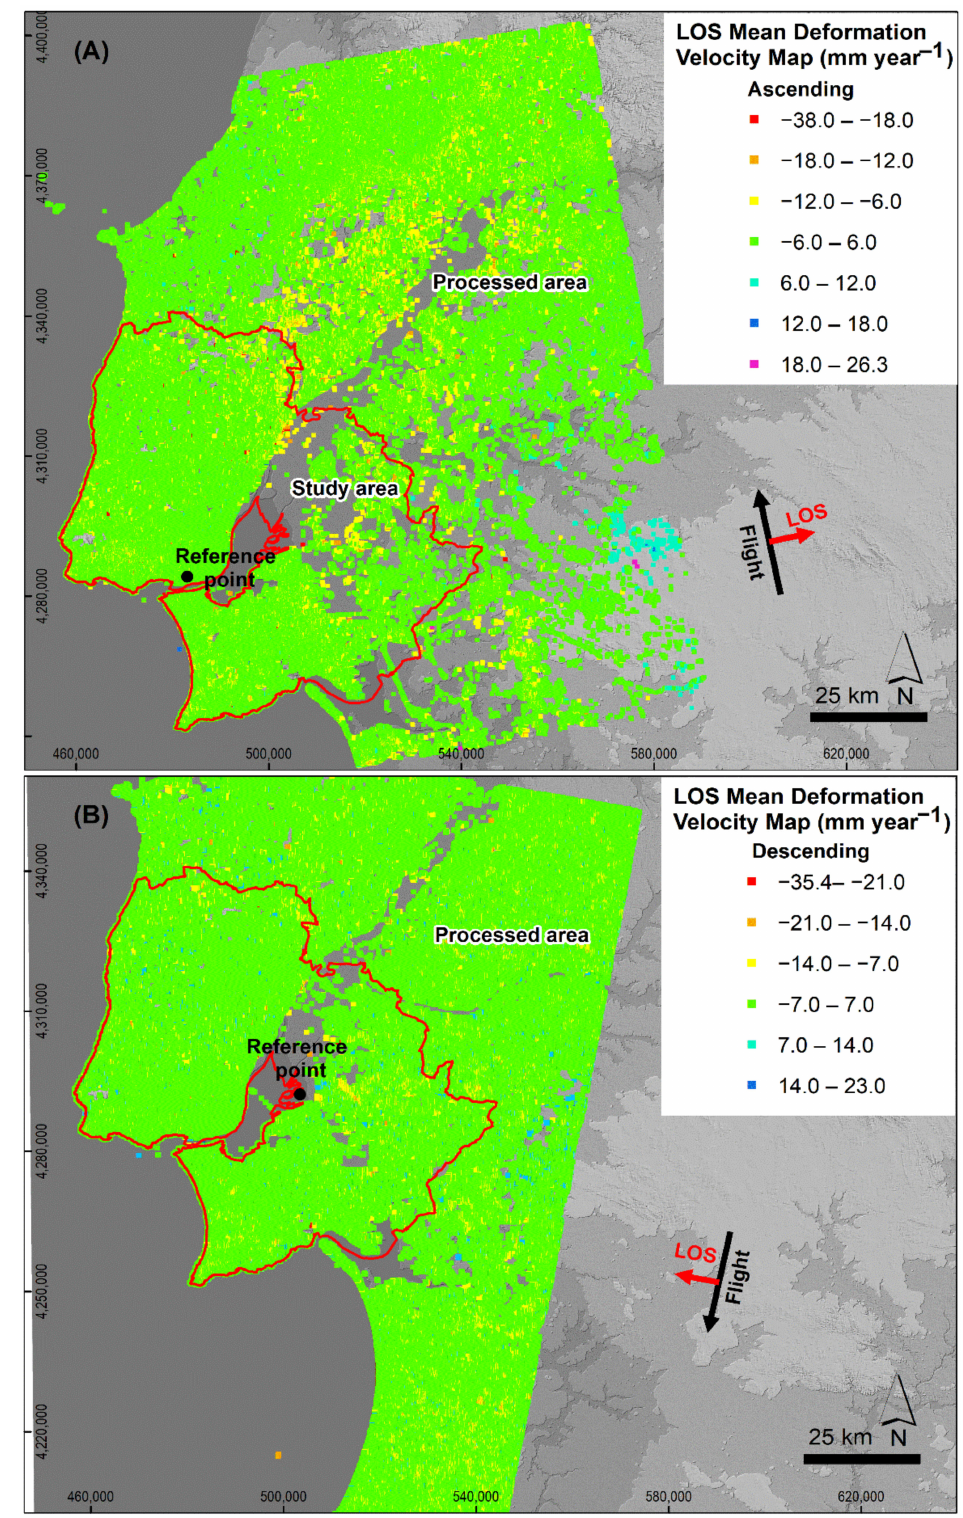
Figure 3. LOS mean deformation velocity maps (mm year − 1 ) for the processed area, with indication of the Lisbon metropolitan area limits (red bounds). ( A ) Ascending trajectory; ( B ) descending trajectory. Black points indicate the location of reference